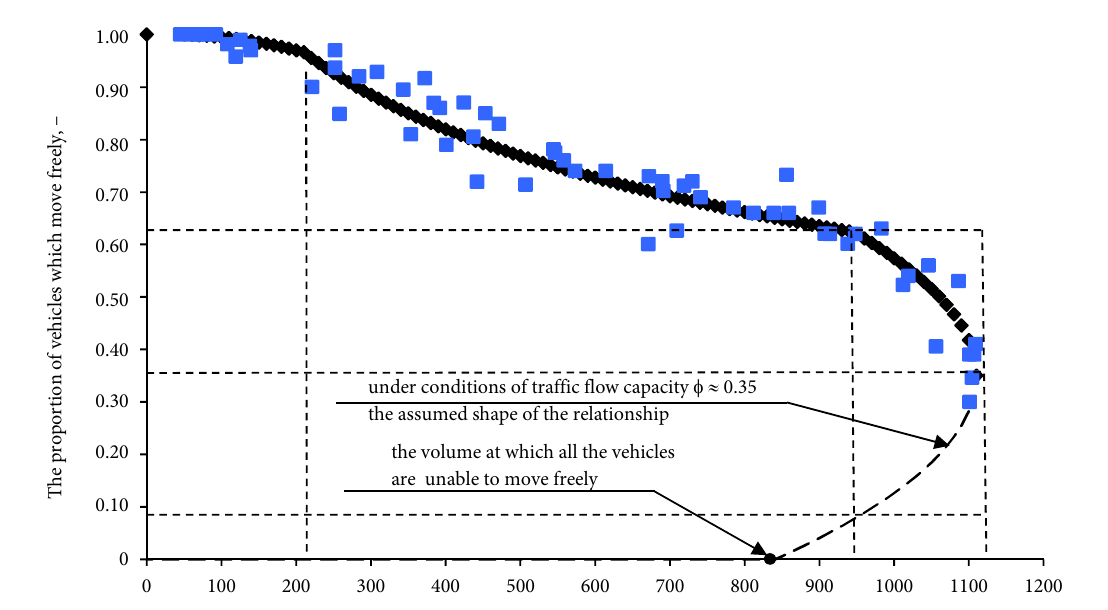
Fig. 2. The dependency of the proportion of vehicles which move freely on the small roundabout on traffic volume amounted to 0.05 which means that standard deviation of residual component amounts to 5% of mean value of the proportion of vehicles which move freely on a road- way of small